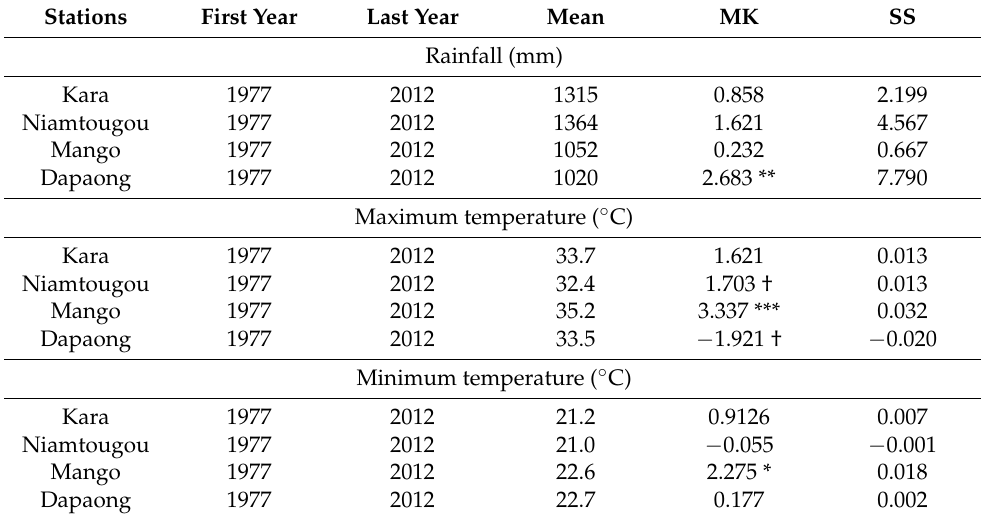
Table 5. Summary of the modified Mann–Kendall (MK) test and Sen’s Slope test (SS) (Trend-Free Pre- Whitening) of the annual total rainfall (mm) and annual minimum and maximum temperature ( ◦